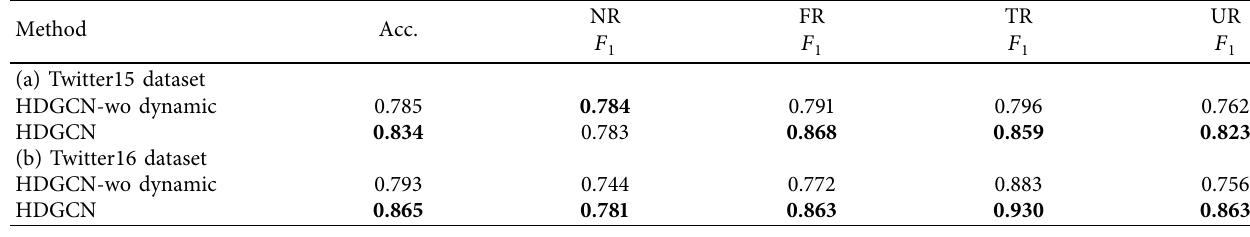
Table 4: The rumor detection performances of with or without dynamic systems on Twitter15 and Twitter16. -wo refers to “without” ODE- based dynamic module.